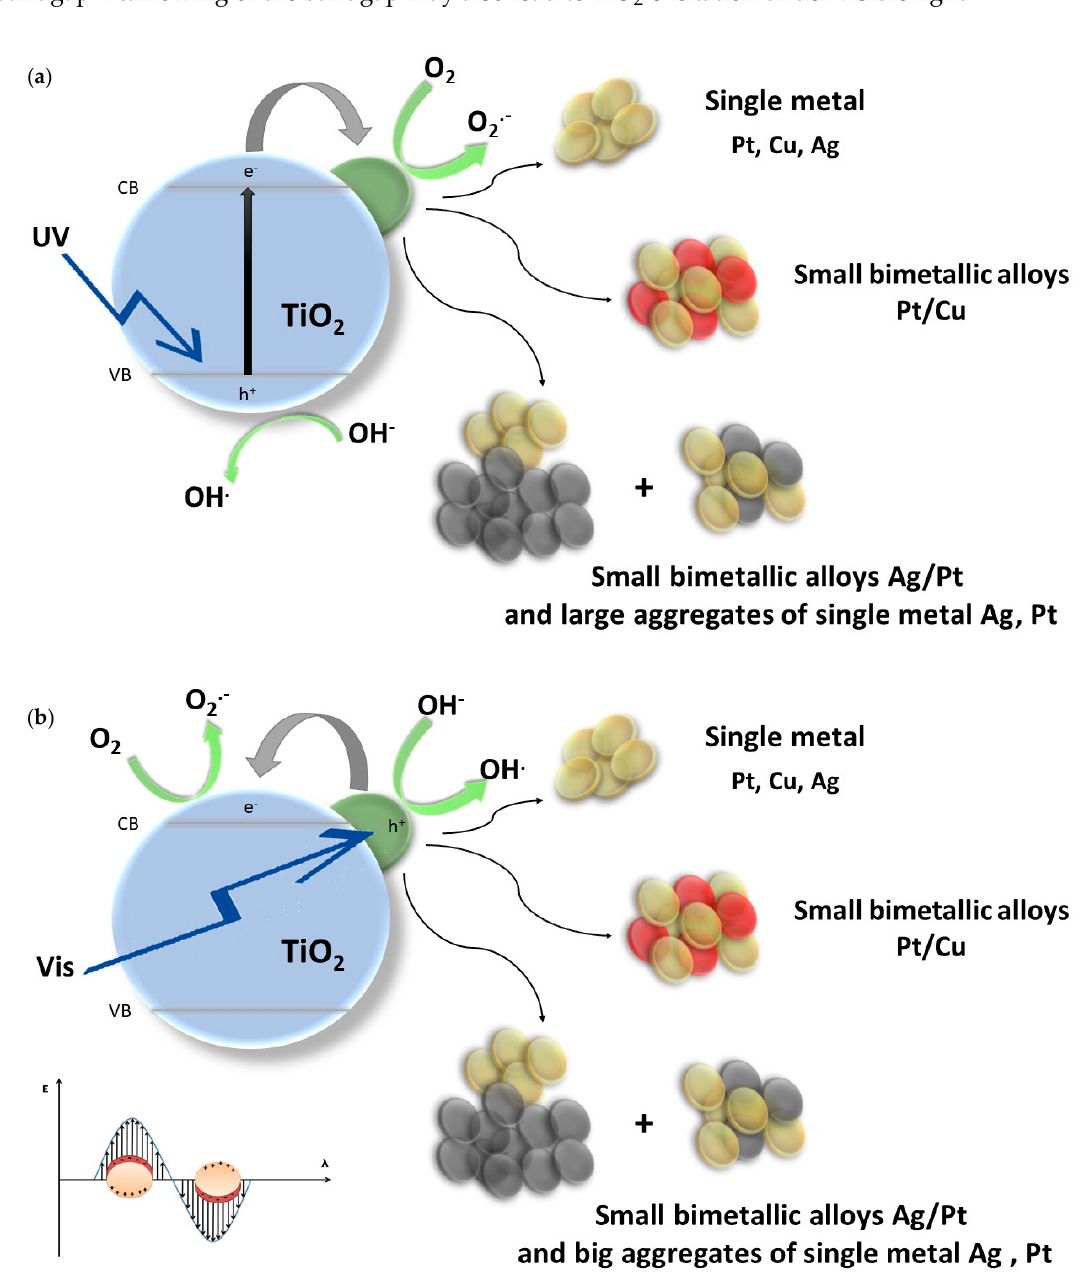
Figure 8. Schematic illustration of metal-TiO 2 nanocomposite excitation under ( a ) UV and ( b ) under Vis.